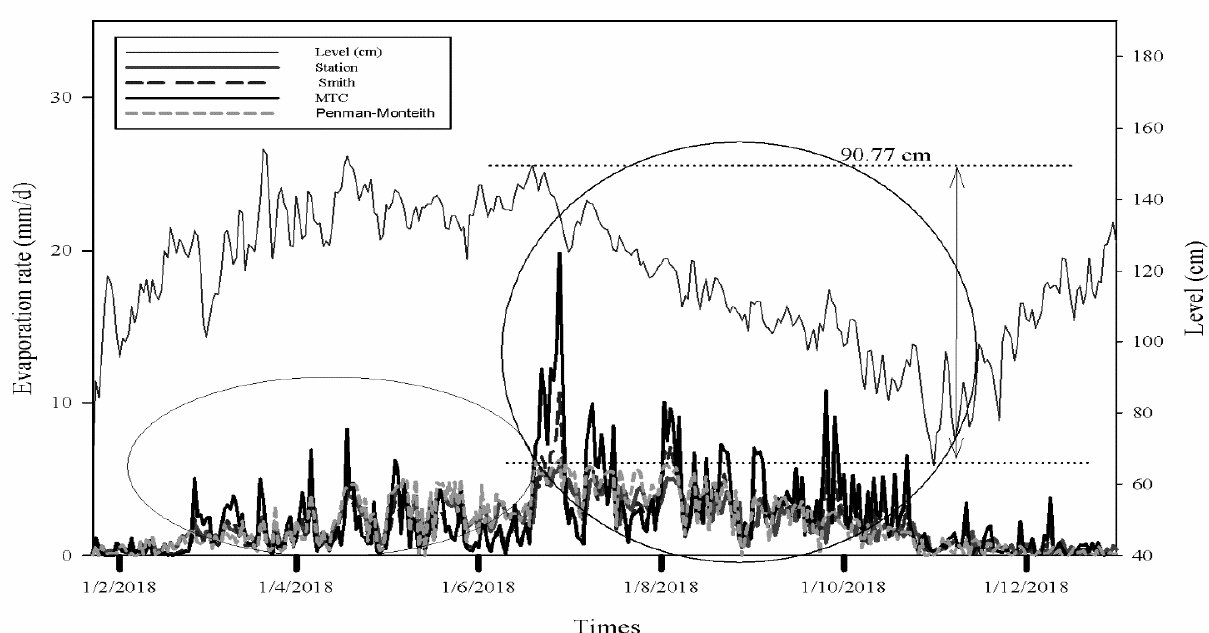
Figure 9. Daily evaporation rates determined using models with rates close to those of the Thomas Pond station for the year 2018.